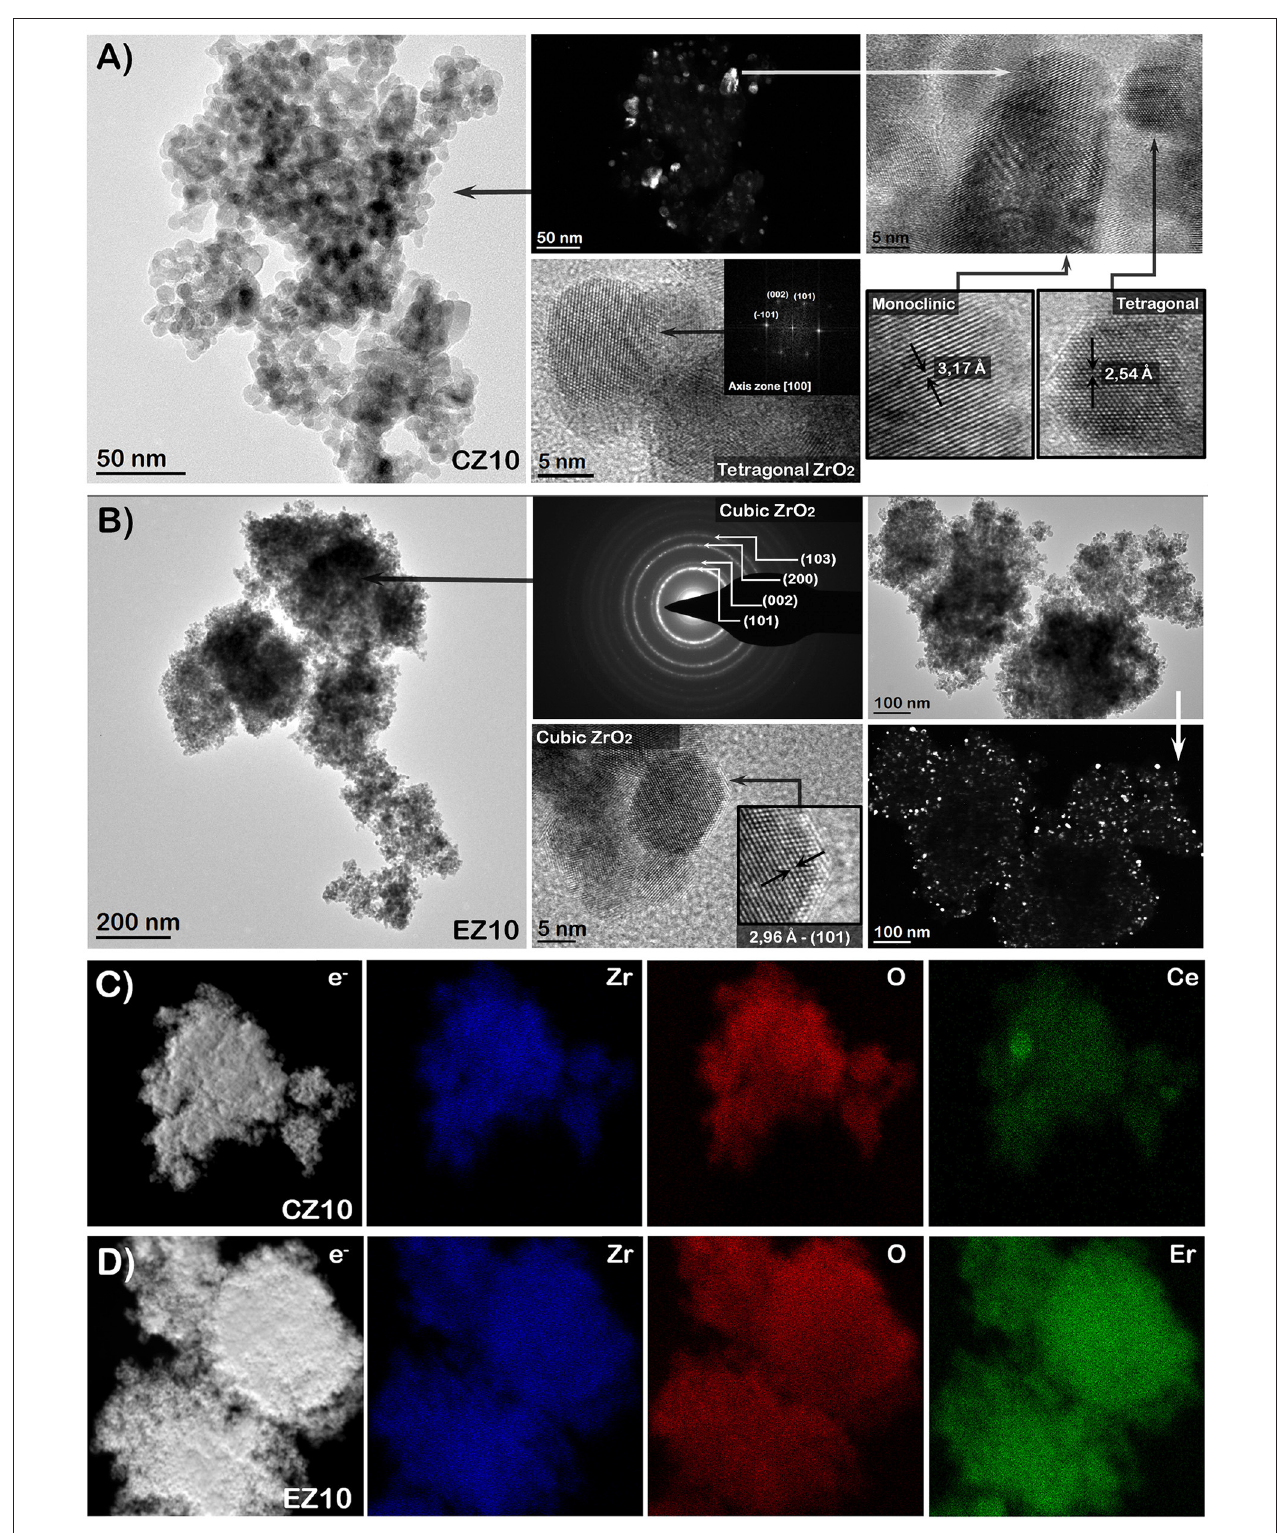
FIGURE 7 | (A,B) TEM (left column) and HR-TEM (center and right columns) images and (C,D) STEM images with EDS maps of RE-doped samples with 10mol % of Ce and Er: CZ10 (A,C) and EZ10 (B,D) , respectively.